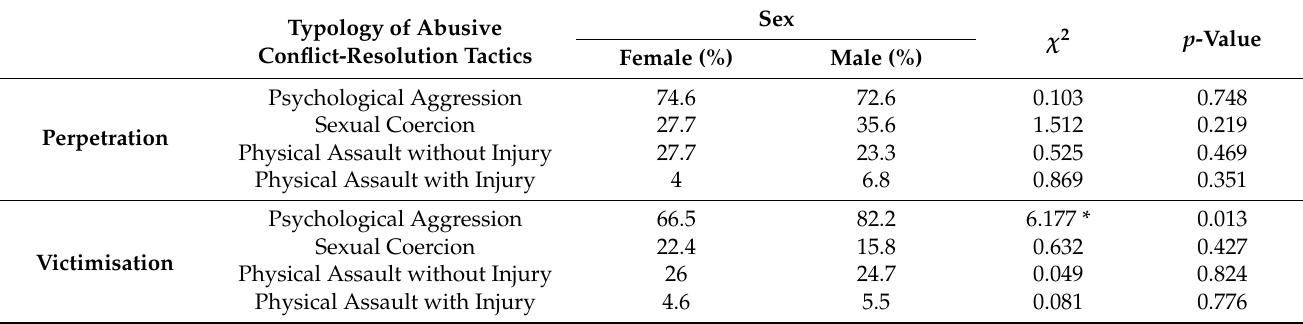
Table 2. Association between typology of abusive conflict-resolution tactics (CTS-2-R) and Partici- pant